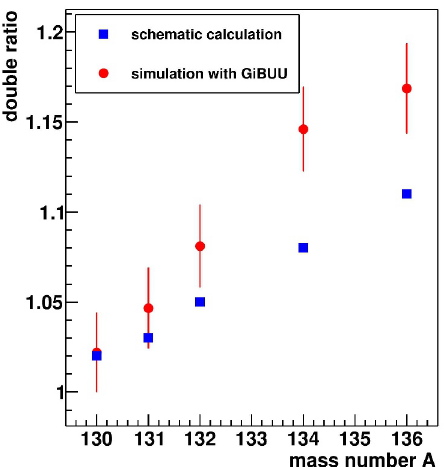
Figure 2. Proton (filled red squares) and neutron (blue points) rms radii of the initial distributions for stable or long-lived xenon isotopes used by the GiBUU simulations. The open red squares show experimental values for the proton radii [3, 4].